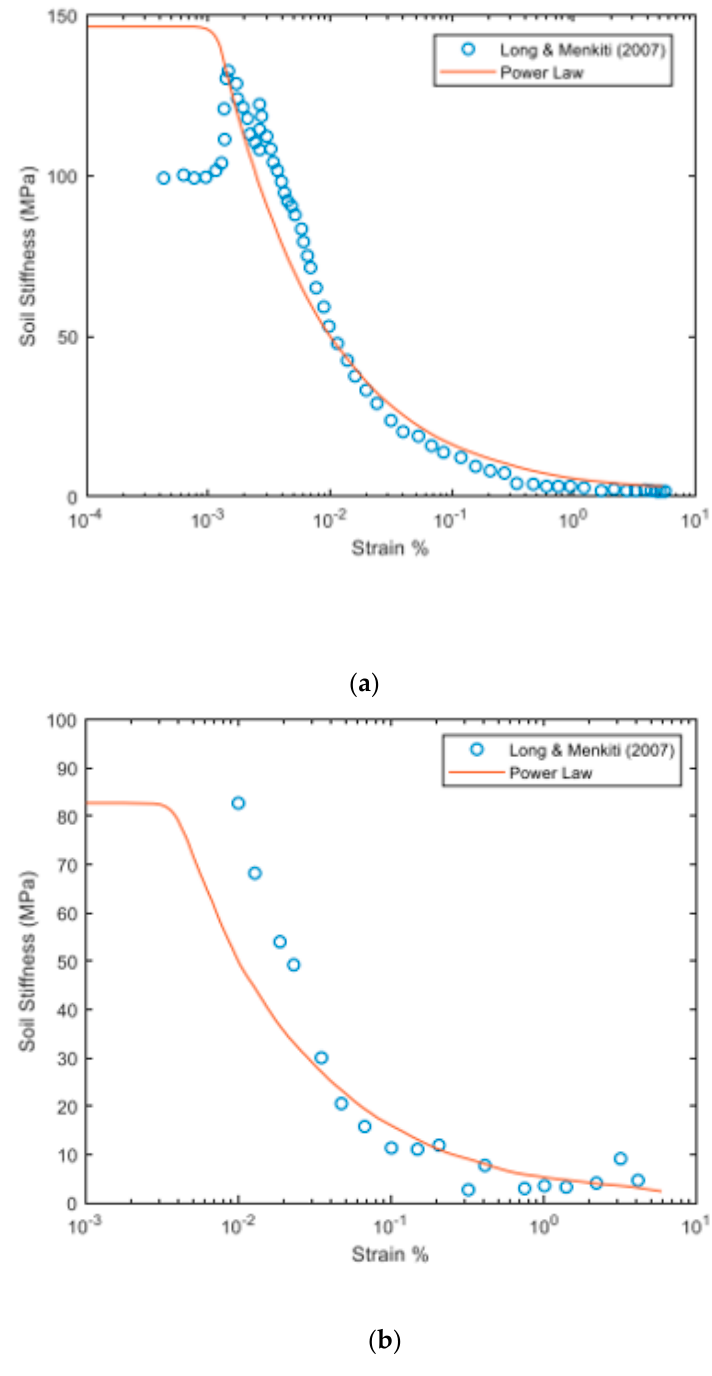
Figure 13. ( a ) Variation of soil stiffness with strains for Upper Brown Boulder Clay. ( b ) Variation of soil stiffness with strains for Upper Black Boulder Clay.